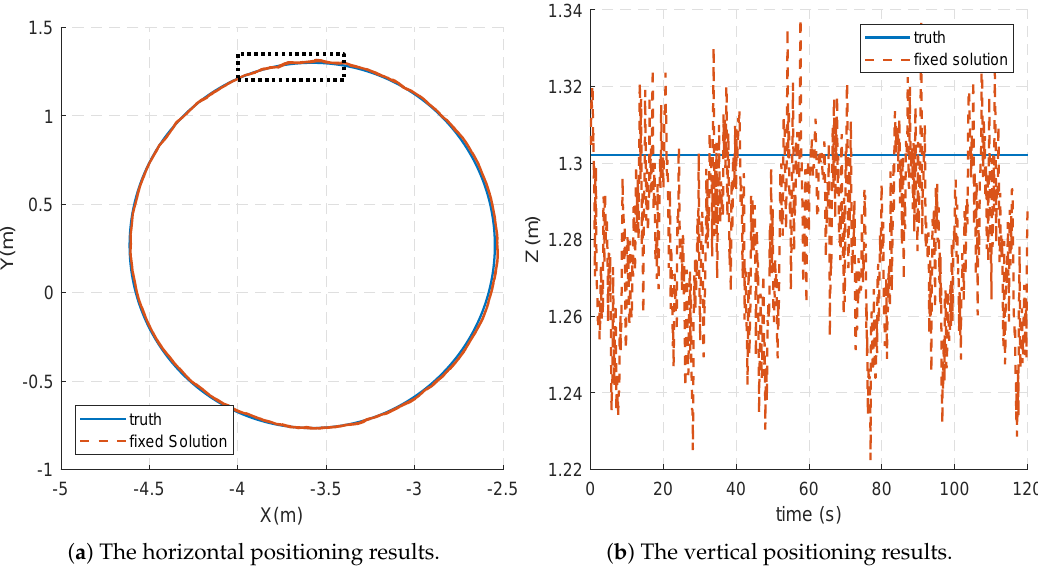
Figure 8. The comparison of the positioning results and the truth.